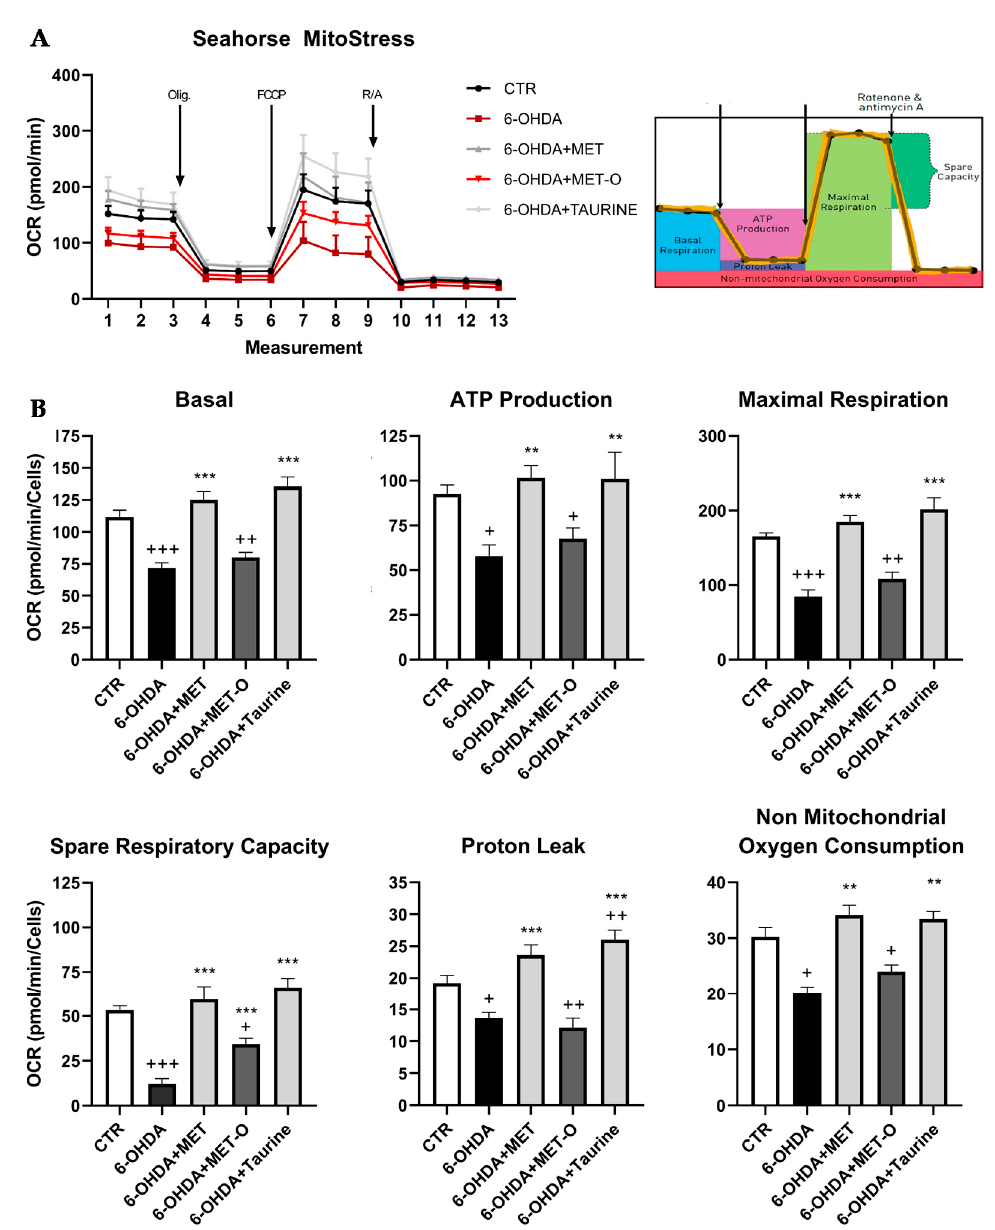
Figure 11. Mitochondrial bioenergetic profile in CTR and treated cells. ( A ) Seahorse XF Cell Mito stress test profile illustrated the key parameters of mitochondrial function upon the injection of the different drugs. ( B ) Graph relative to basal respiration, ATP production, maximal respiration, and non-mitochondrial respiration in control and treated cells. Data are mean ± SD of 3 different experiments. *** p < 0.0001, ** p < 0.005 vs. 6-OHDA; +++ p < 0.0001; ++ p < 0.005; + p < 0.05 vs. CTR.